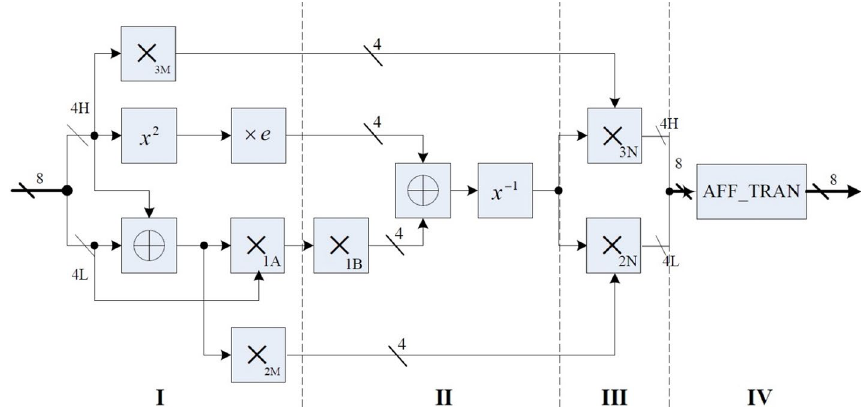
Fig. 8 Pipelined Subbytes in composite field GF((2 4 ) 2